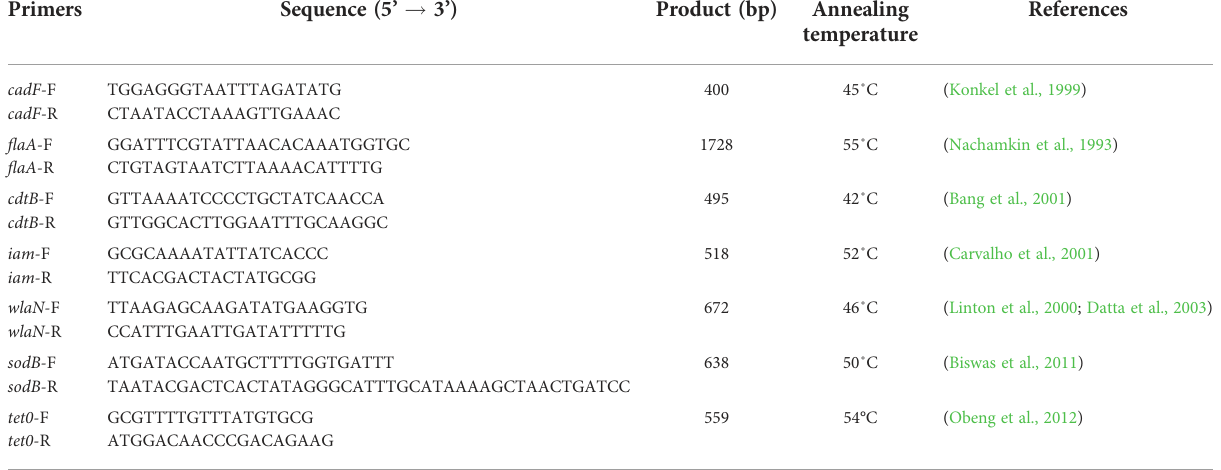
TABLE 1 Sequences of primers, annealing temperatures, and product